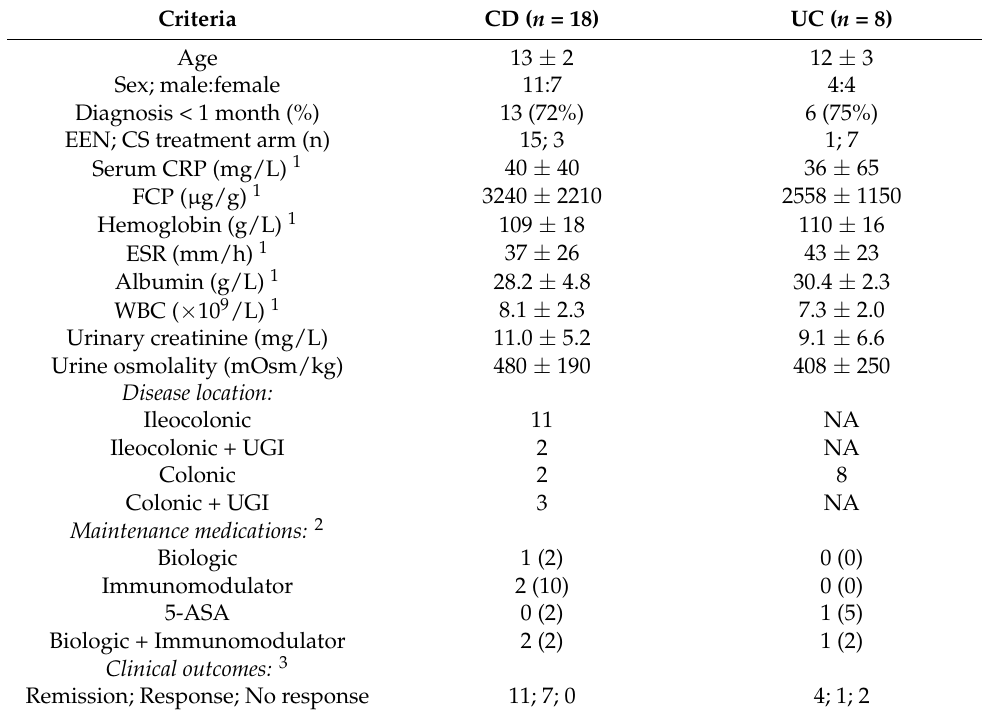
Table 1. Pediatric patients diagnosed with inflammatory bowel disease (IBD) with clinical measure- ments based on mean values and errors as ± 1 SD. All biochemical measurements were derived from serum, urine or stool, whereas disease location was based on endoscopy and magnetic resonance enterography